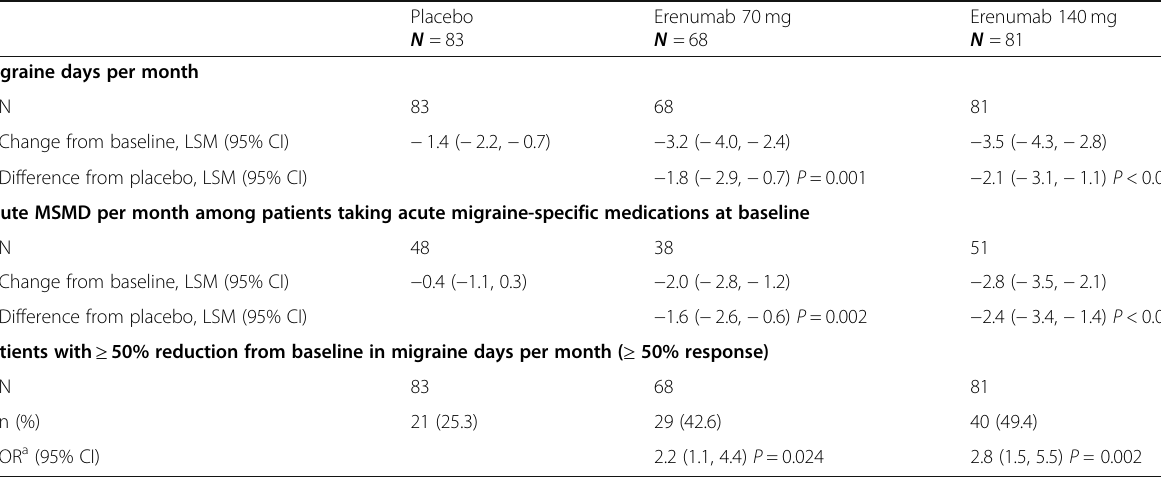
Table 2 Efficacy over months 4 – 6 of the double-blind treatment phase